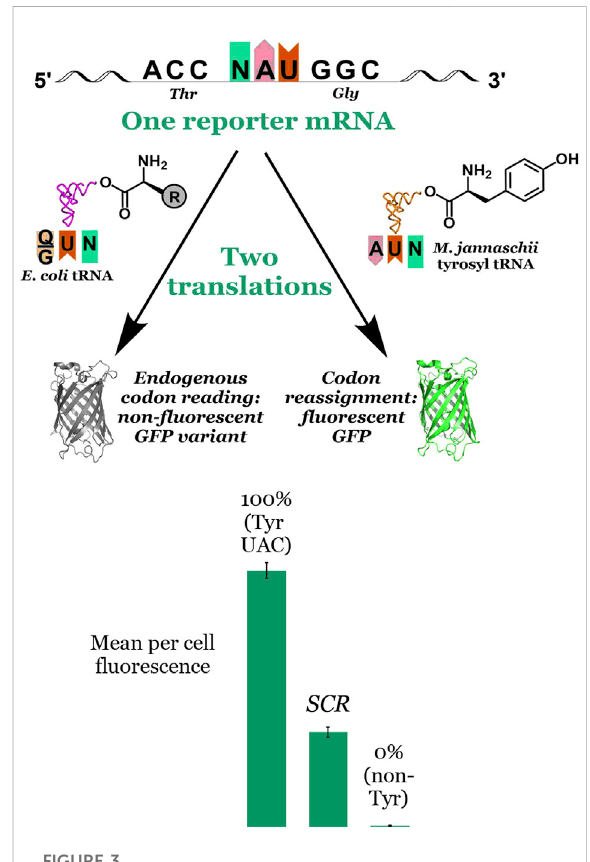
FIGURE 3 Principle ofanddatavisualizationfor the fl uorescence-based screen for codon reassignment. The fl uorescence-based screen exploits the absolute requirement of tyrosine at position 66 in superfolder GFP for fl uorophore formation. Reporter vectors with another codon at that position are co-transformed with the M.jannaschii tyrosylaminoacyltRNAsynthetaseandavariantofits cognate tRNA. Both the engineered orthogonal tRNA and endogenous tRNAs (with either Q or G at position 34) compete to decode the evaluated codon. Incorporation of tyrosine by the orthogonal tRNA in response to the codon at position 66 in the GFP reporter leads to production of fl uorescent protein. Incorporation of a different canonical amino acid by the endogenous translation machinery leads to production of non- fl uorescent protein. The mean per cell fl uorescence of the system under evaluation is bracketed between a 100% fl uorescence reference system in which the codon at position 66 encodes tyrosine and a 0% fl uorescence reference system in which the codon at position 66 encodes another amino acid. The middle bar labelled “ SCR ” represents the intermediate per cell fl uorescence observedforahypotheticalsystemunderevaluation.Inthisreport, SCR ef fi ciencies range from 2.1% to 13.4% depending on the system. More broadly, we have reported SCR ef fi ciencies between 1.0% and 70% using the M. jannaschii orthogonal